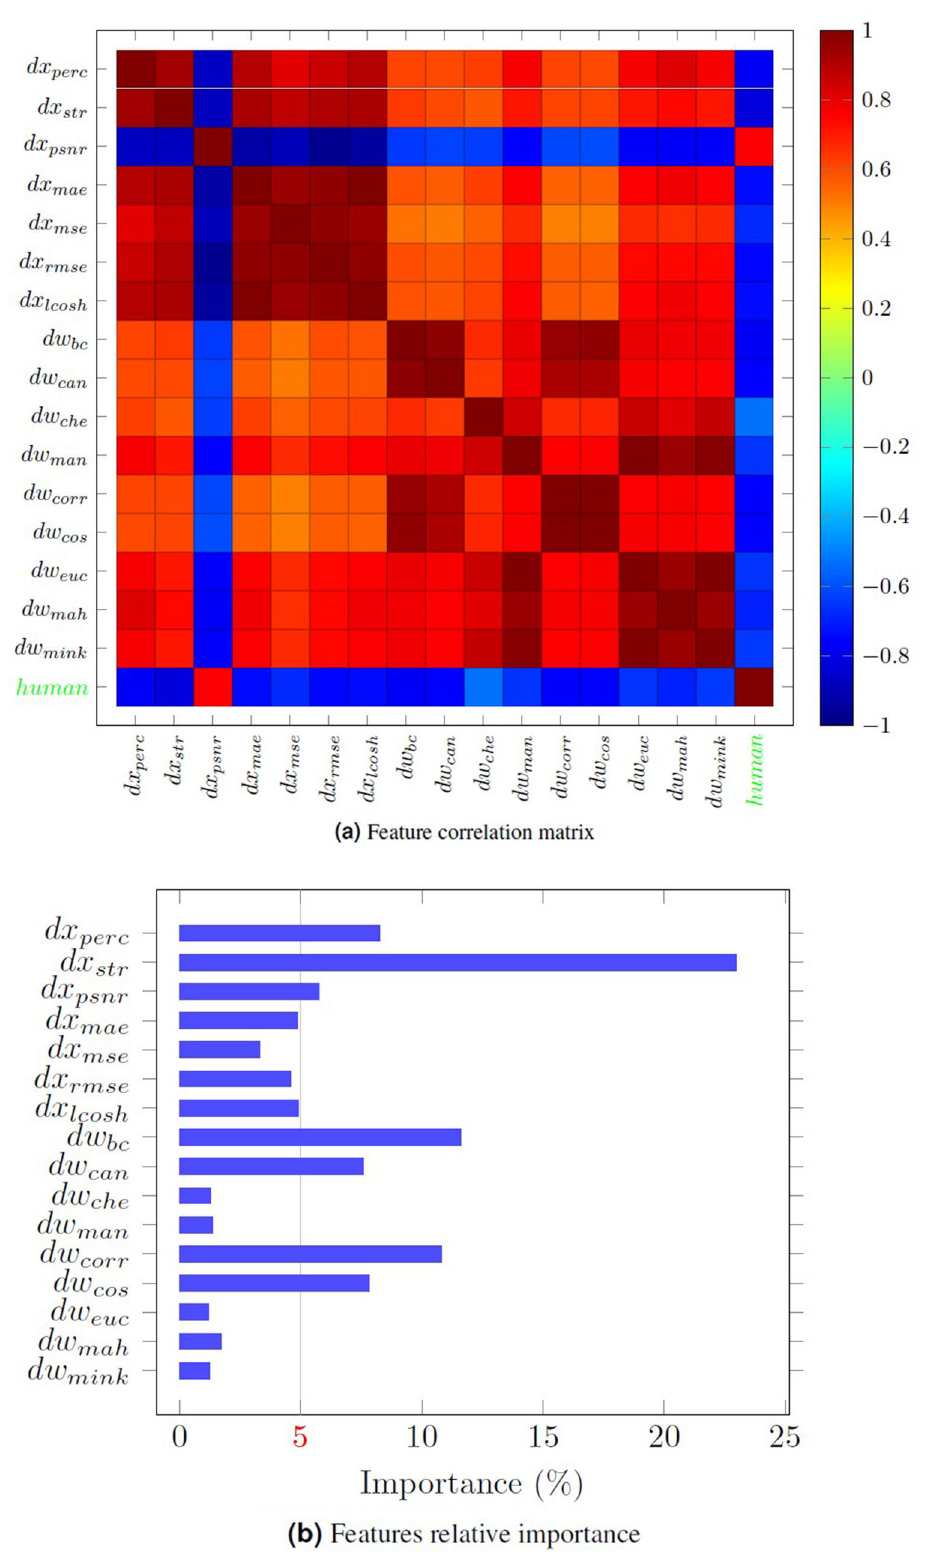
Figure 6. Assessment of extracted features. ( a ) is a matrix demonstrating the correlation between seven different image distance measures, nine different latent distance measures, and human image ratings. ( b ) shows the relative importance of the 16 extracted features using ERT algorithm (see